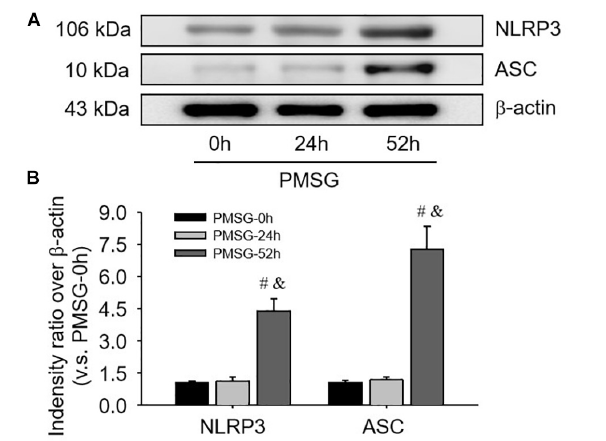
FIGURE 3 | NLRP3 and ASC protein expressions in the ovary during the